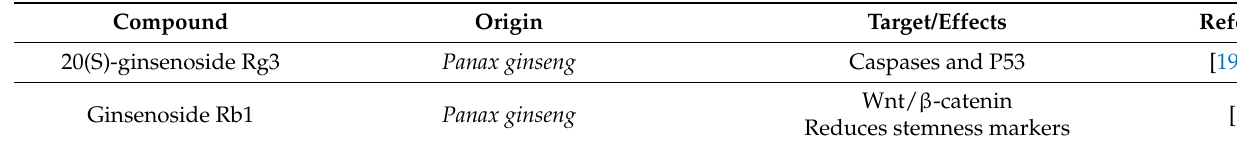
Table 2. CSC-targeting therapeutic